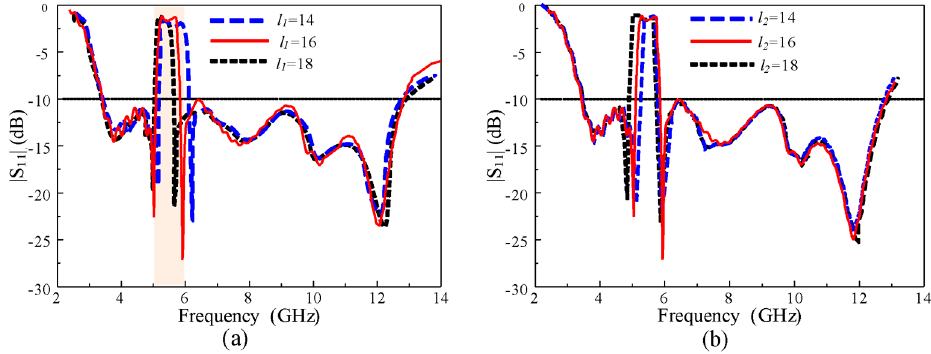
Figure 10. | S 11 | of the antenna for di ff erent lengths of: ( a ) EBG1 l 1 , and ( b ) EBG2 l 2 Figure 10. |S 11 | of the antenna for different lengths of: ( a ) EBG1 l 1 , and ( b ) EBG2 l 2 .